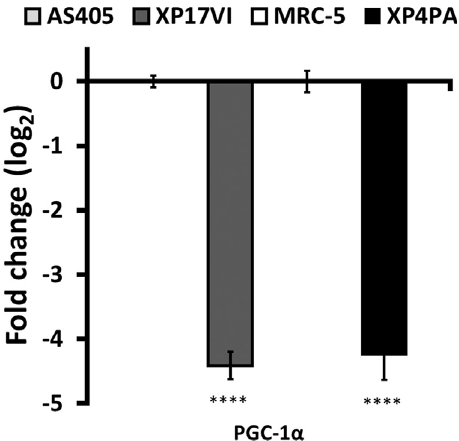
Figure 1 - PGC-1 (cid:2) is differentially expressed in XP-C cells. PGC-1 (cid:2) ex- pression levels were measured in the following cell lines: matched human primary fibroblasts, AS405 (WT) vs. XP17VI (XPC (cid:3) TG/ (cid:3) TG), and SV-40 immortalized human fibroblasts, MRC-5 (WT) vs. XP4PA(XPC (cid:3) TG/ (cid:3) TG ). Results are shown as mean±SD, n=4. * p <0.05, ** p <0.01, *** p <0.001 and **** p